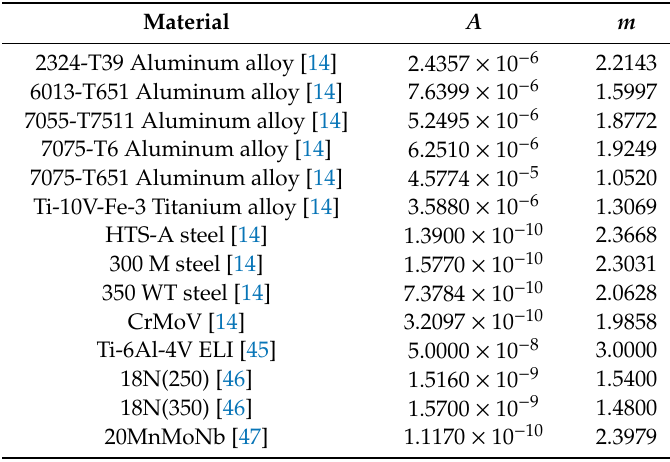
Table 1. Data of model parameters for common materials used in marine structures [14,45–47].